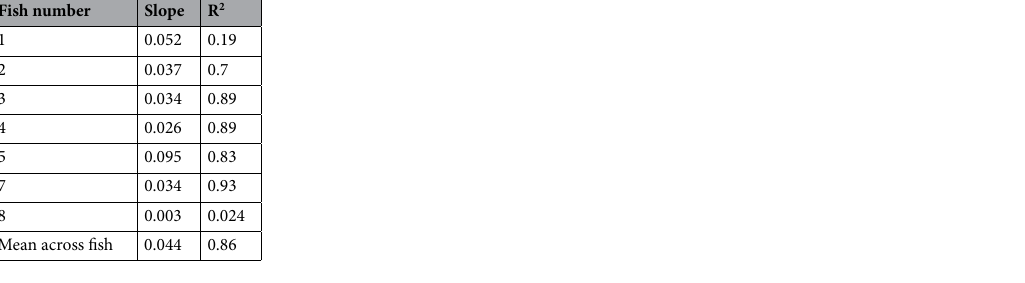
Table 4. Slope and lienar fith for C1–C4. The slope is the ‘m’ value in the function y = mx + n. R 2 refers to the fit to the linear function.